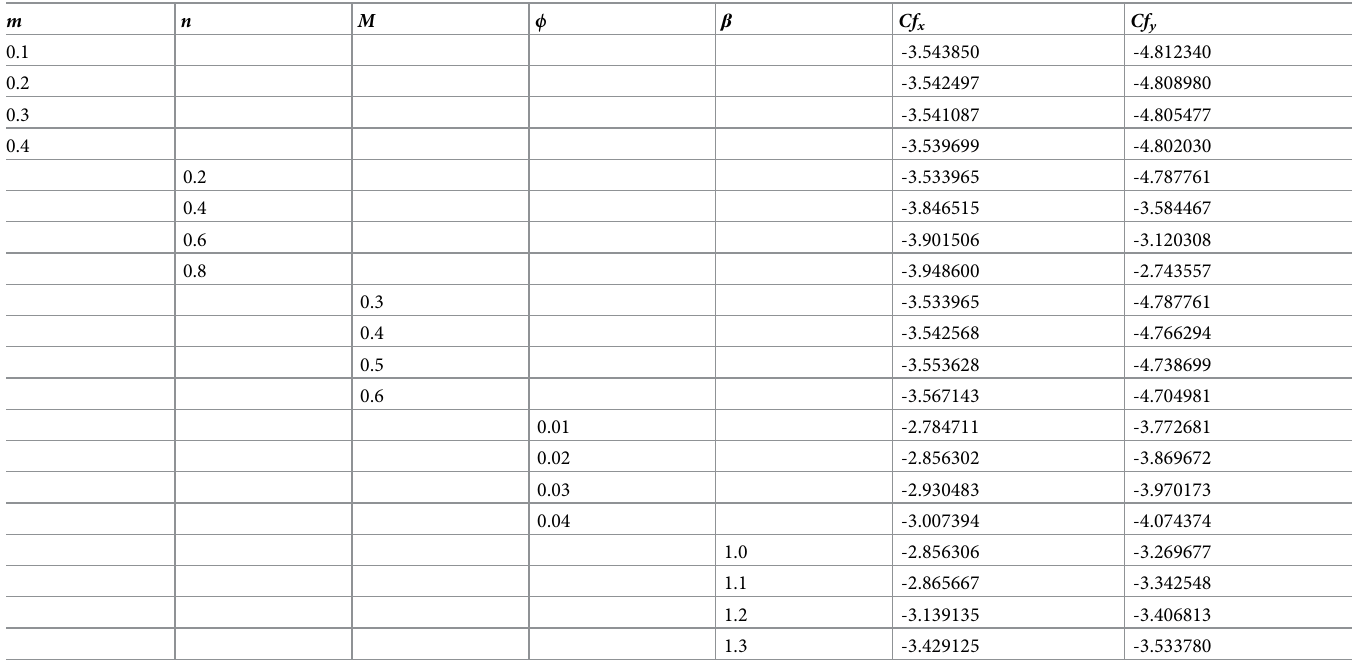
Table 3. Skin friction coefficients Cf x and Cf y variation against m , n , M , ϕ and β